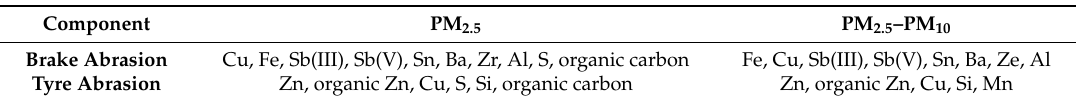
Table 2. Dominant chemical, coarse and fine constituents of PM 10 , occurring as oxides from the trace metals presented (based on [47]).